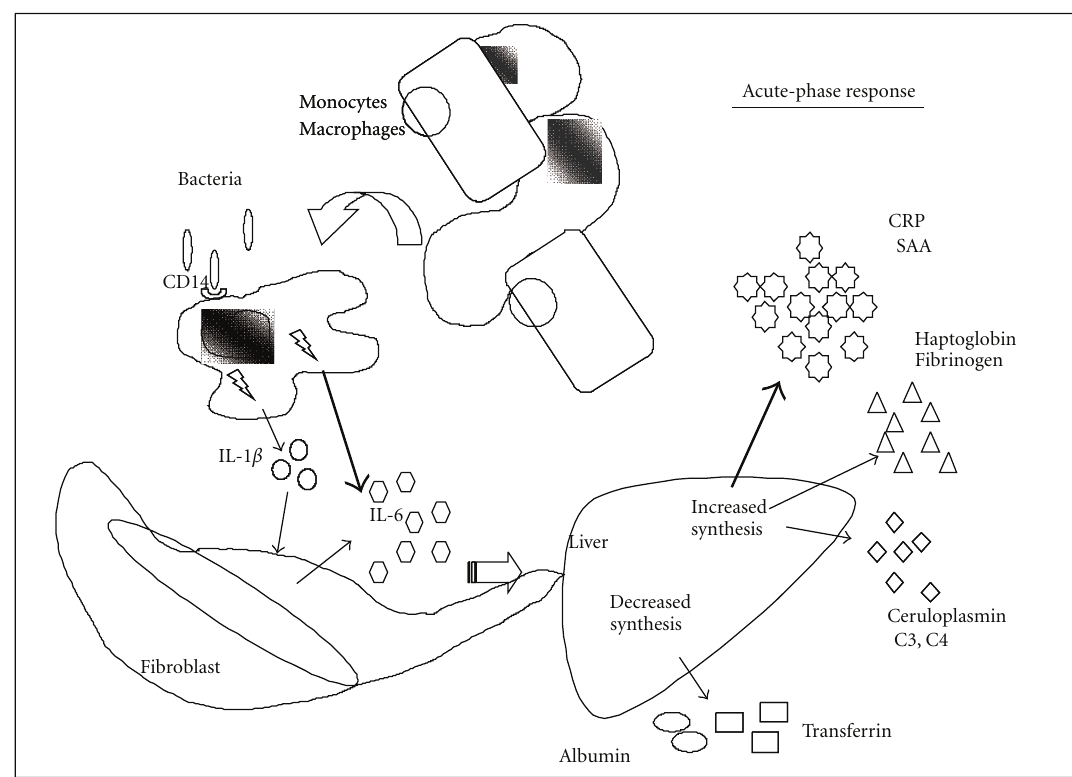
Figure 2: Acute phase of